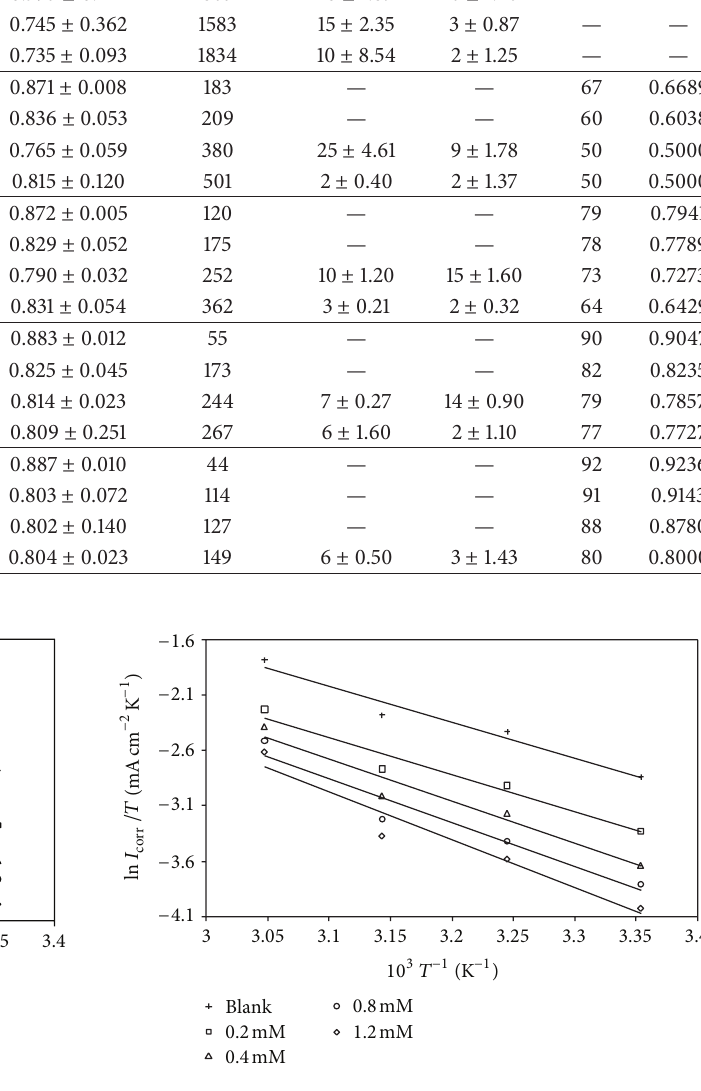
Figure 14: Arrhenius plots of corrosion ln( 𝐼 HCl at different concentrations of